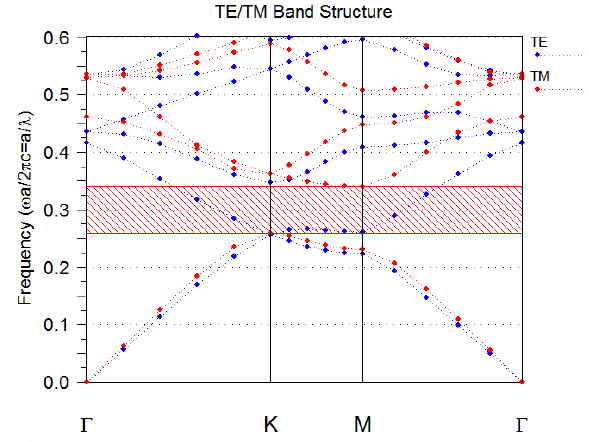
Fig.2. Band structure of the photonic crystal structure.